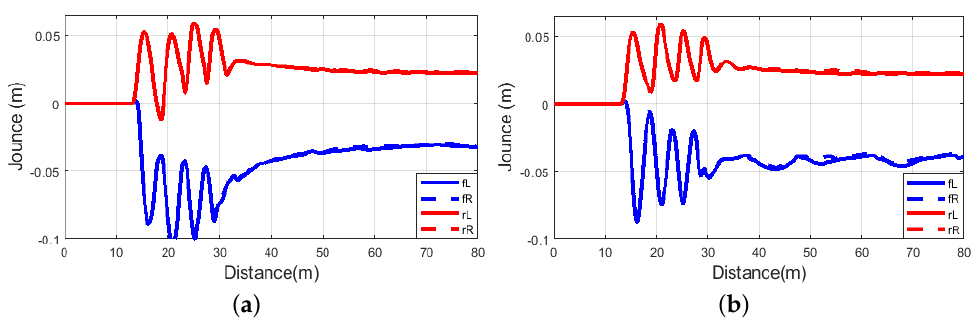
Figure 18. ( a ) Suspension deflection of road roughness, ρ = 1. ( b ) Suspension deflection of road roughness, ρ =